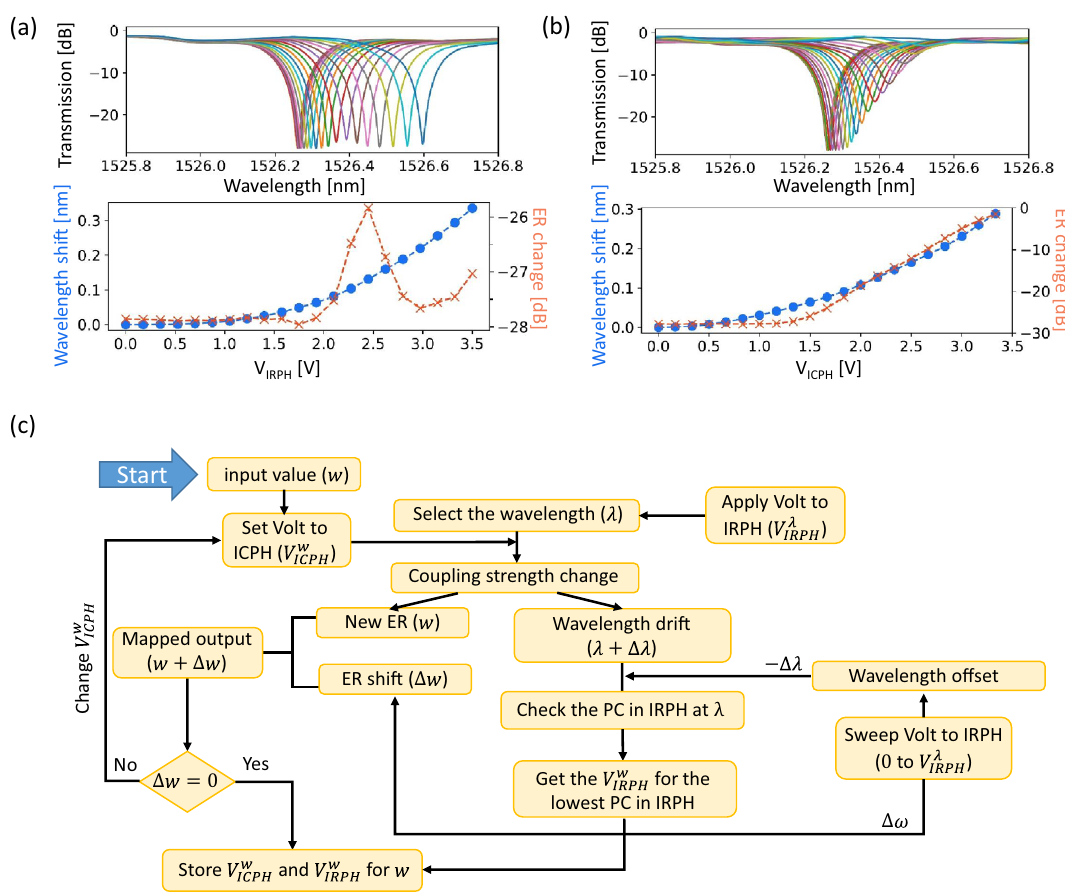
Figure 3. ( a ) Measured transmission spectra of the proposed IM-MRM after normalization when a voltage is applied to the IRPH from 0 to 3.5 V, as well as the extracted wavelength shift and ER change ( b ) Measured transmission spectra of the proposed IM-MRM after normalization when a voltage is applied to the ICPH from 0 to 3.5 V, as well as the extracted wavelength shift and ER change. ( c ) Flow diagram of the intensity-modulation algorithm. PC: